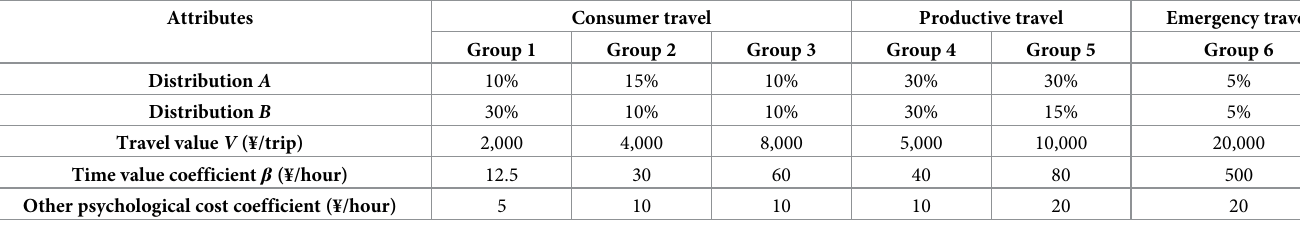
Table 3. Main parameter assumptions for certain travel demand